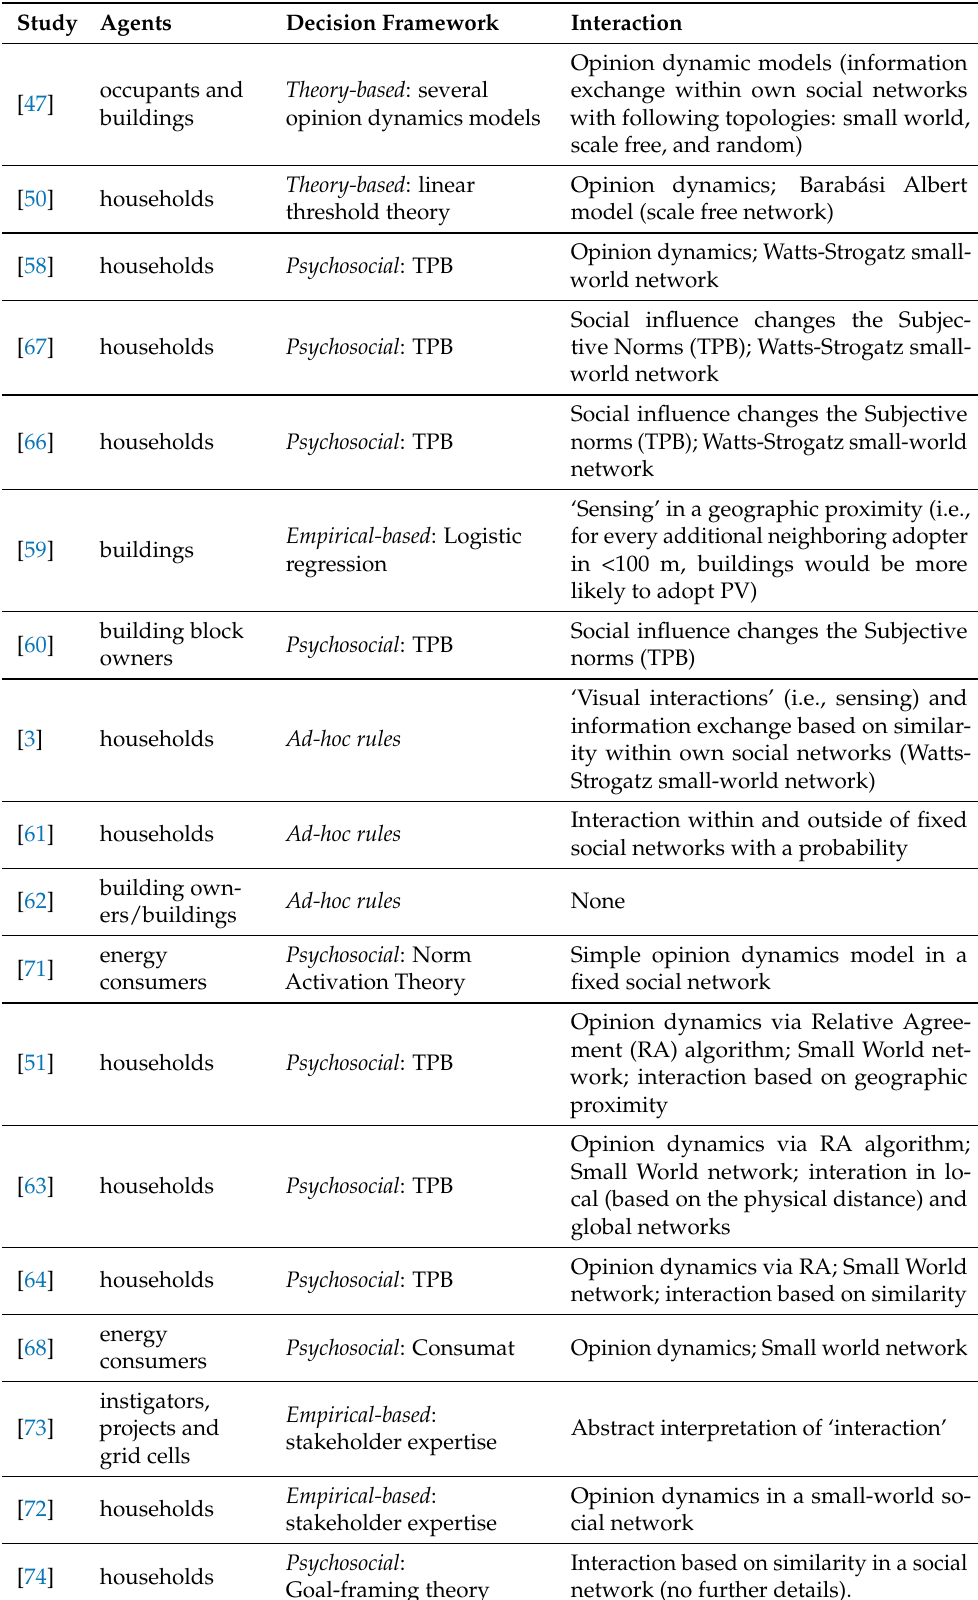
Table 3. Agents, decision frameworks and representation of agent